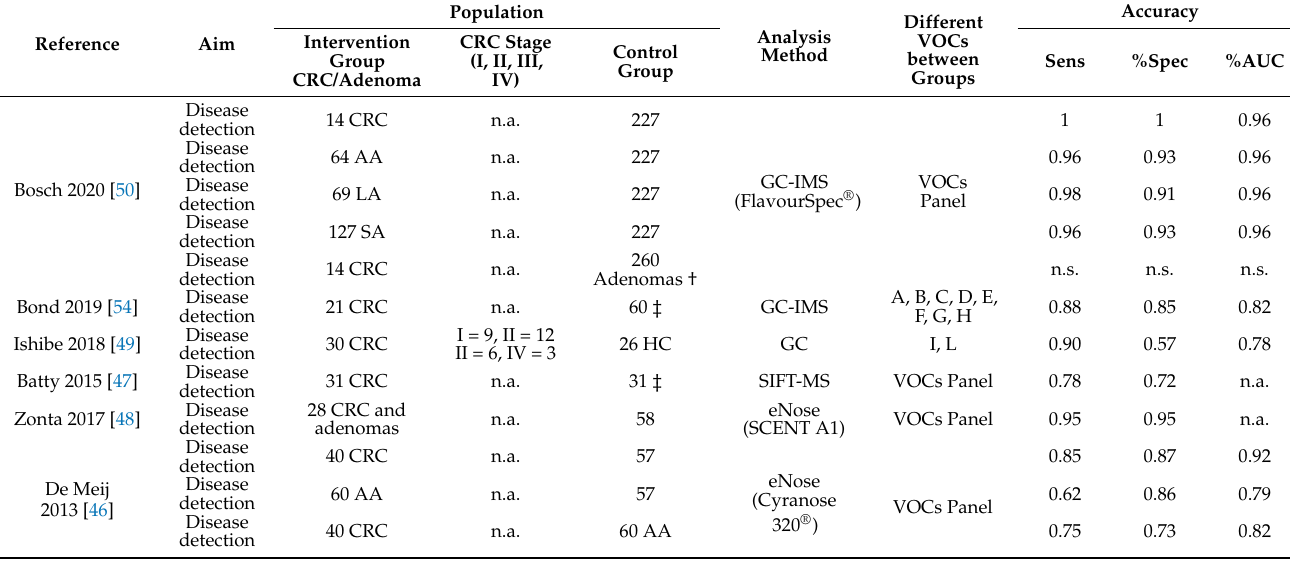
Table 3. Fecal VOCs and colorectal cancers or adenoma